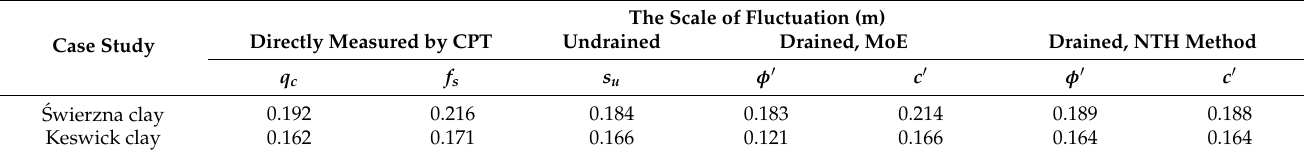
Table 8. The scale of fluctuation values for each method of estimation of strength